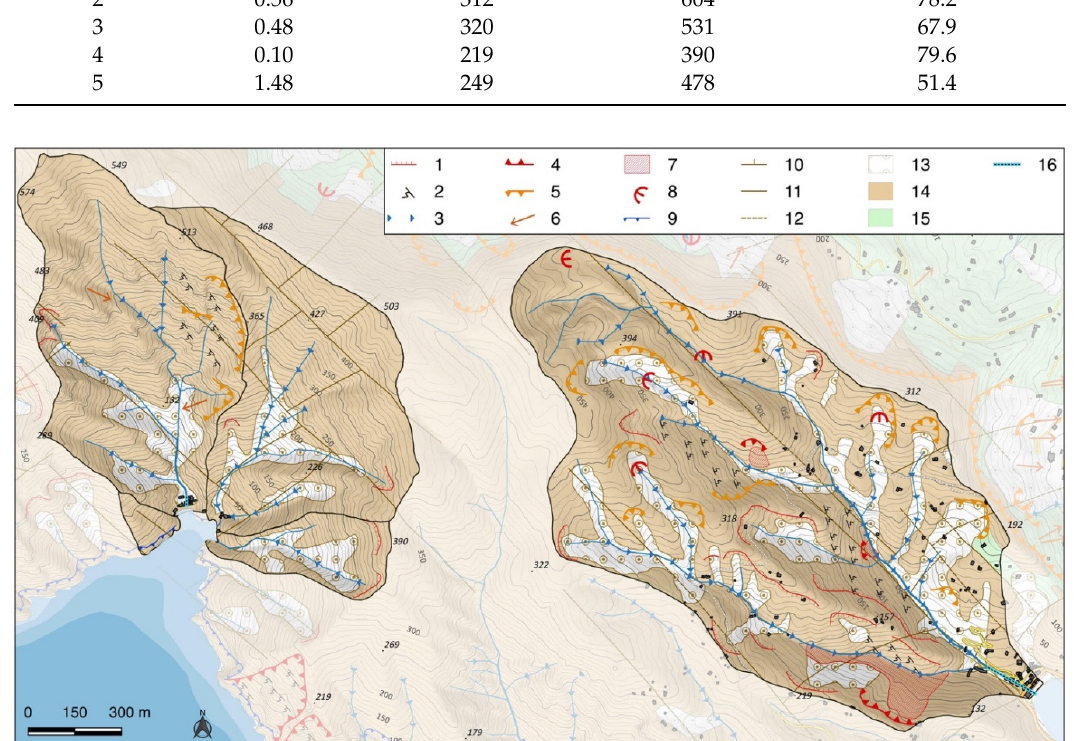
Figure 3. Geological/geomorphological sketch of the studied catchments. (1) Fluvial erosion scarp; (2) surface affected by rill/inter-rill erosion; (3) incising riverbed; (4) landslide scarp, active; (5) landslide scarp, inactive; (6) isolated fallen/toppled block; (7) landslide, active; (8) shallow landslide, soil slip; (9) erosional coastal scarp; (10) bedding; (11) certain fault; (12) presumed fault; (13) debris cover; (14) Conglomerates with sandstone layers; (15) marly limestones, clayey shales, siltstone and marls; (16)